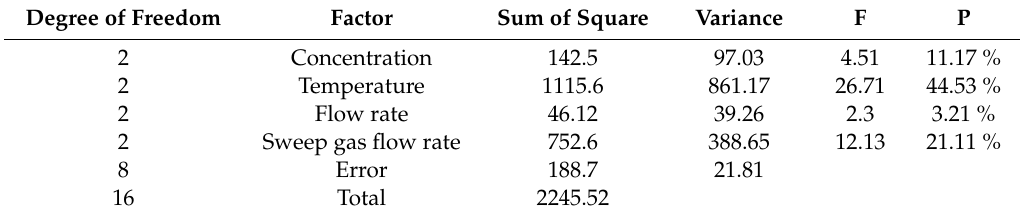
Table 7. Parameters of the statistical